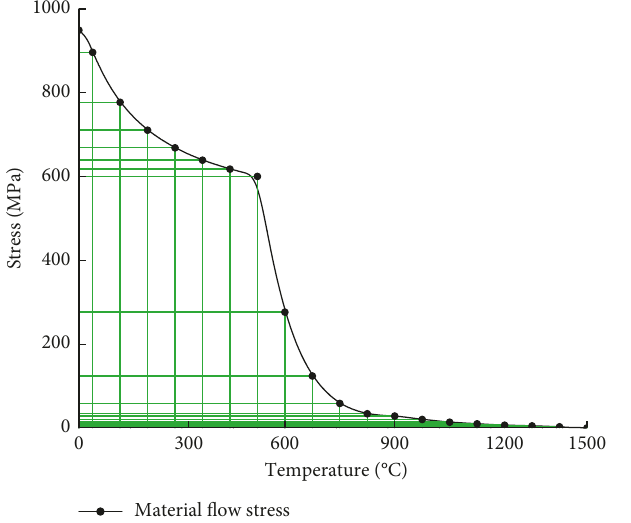
Figure 4: Material flow stress vs. temperature.